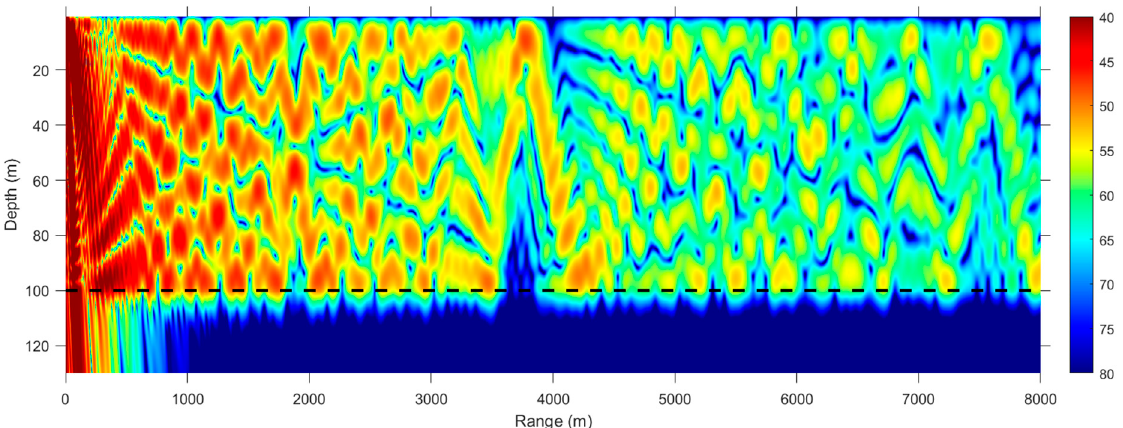
Figure 8. The TL contour in the Pekeris waveguide case using the SFD with PPW = 20 (the black dotted line shows the seabed).